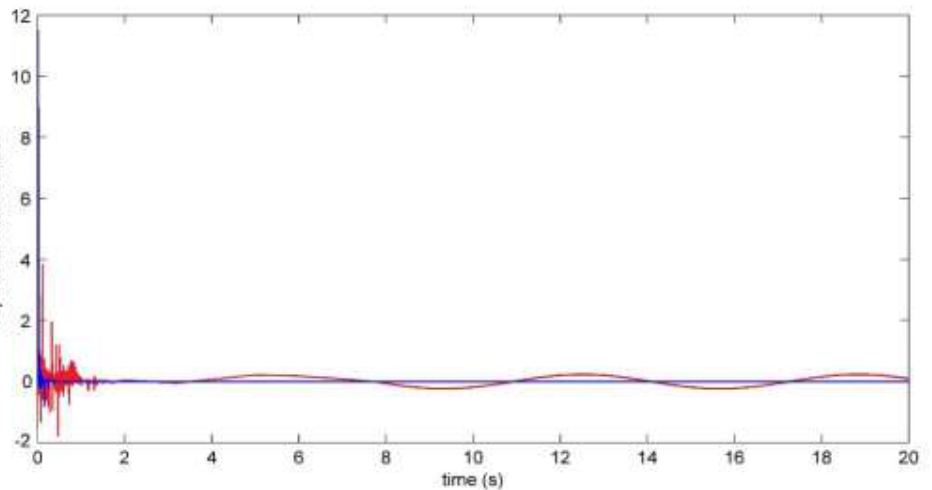
Figure 8. Second level hierarchical terminal sliding surface vs. time (blue and red solid lines represents the AFHTSMC and the AFHSMC top hierarchical surface, respectively).